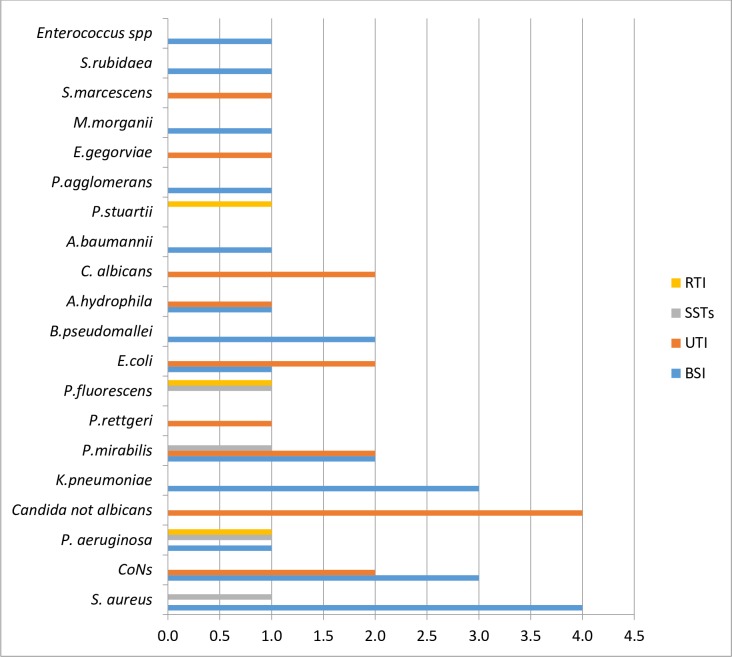
Distribution of Causative microorganisms by the sites of Intensive Care Unit–acquired infections in Lagos University Teaching Hospital, Lagos.KEY: RTI = Respiratory tract infections; SSTs = Skin-soft tissue infections; UTI = Urinary tract infections; BSI = Blood stream infections; CoNS = Coagulase negative staphylococcus.